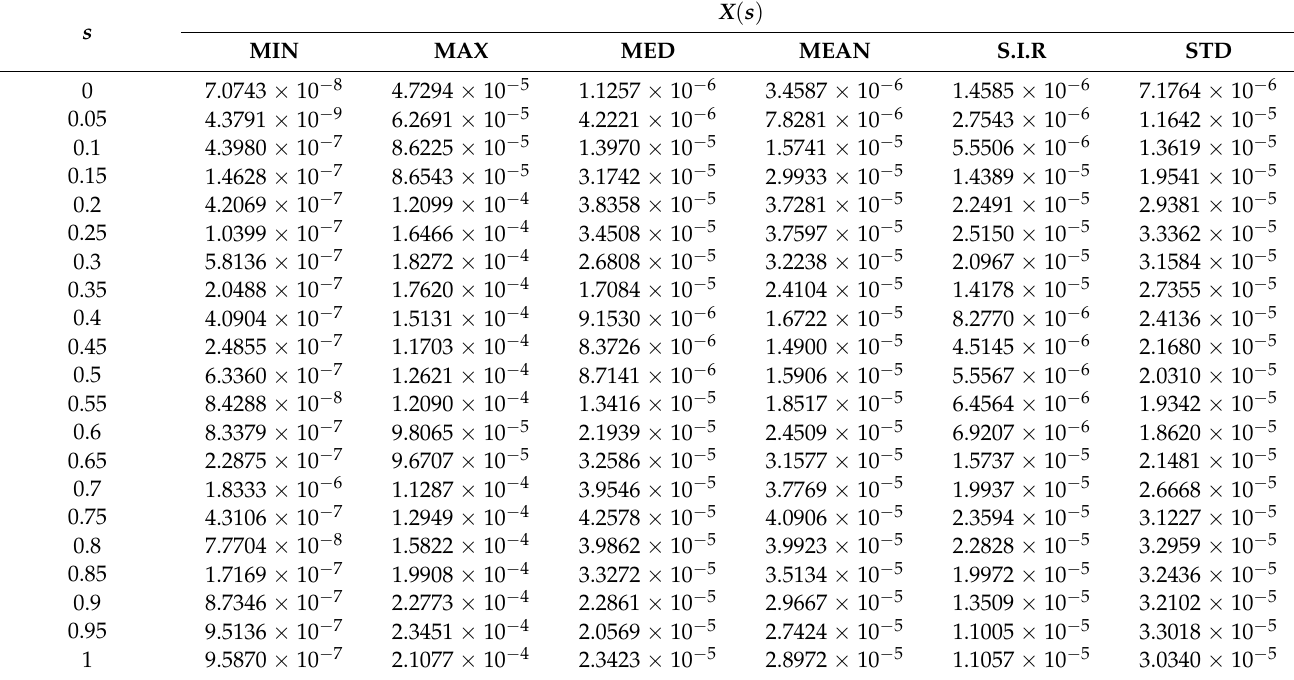
Table 2. Statistical presentations of the environmental and economic nonlinear model for X ( s ) .